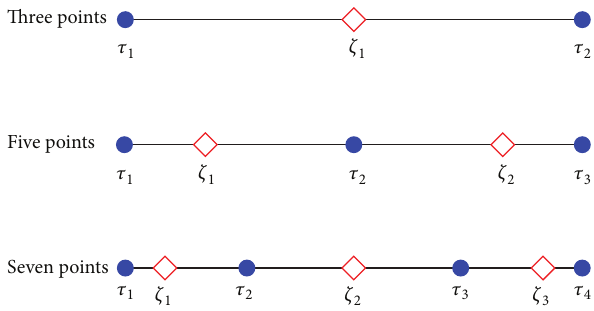
Figure 3: Three, five, and seven Legendre-Gauss-Lobatto points.